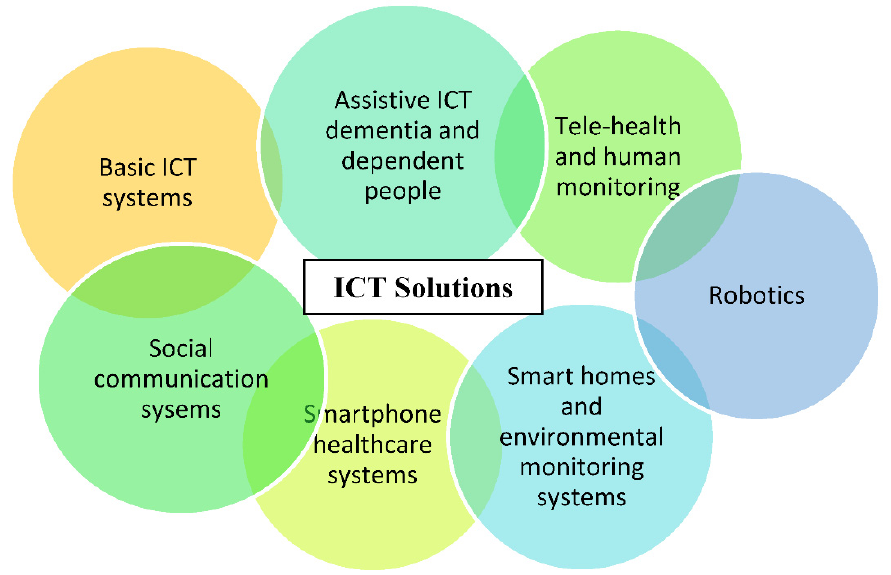
Figure 5. Different categories of ICT solutions from the simplest technologies (e.g., basic ICT) to the more complex solutions (e.g., smart homes and telehealth).